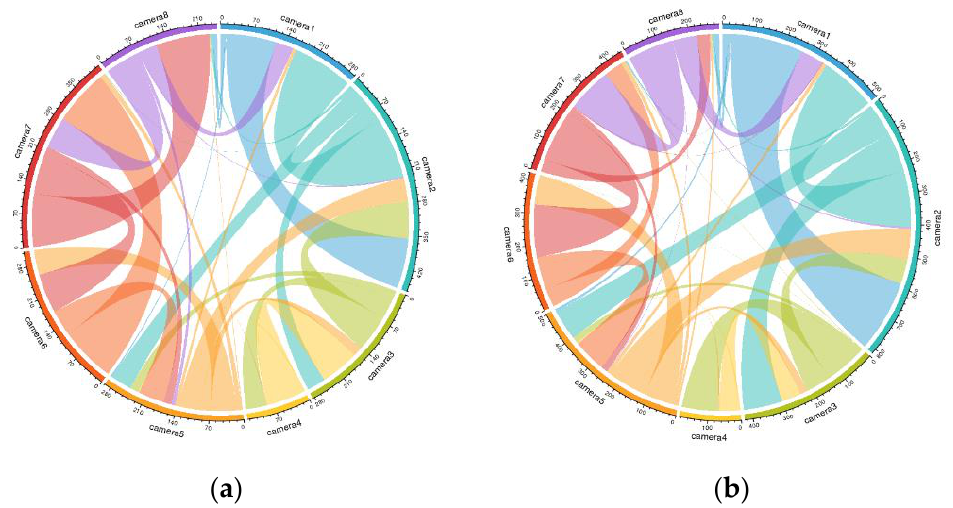
Figure 6. Pedestrian O – D flow in the first half hour ( a ) and the second half ( b ) of the video.